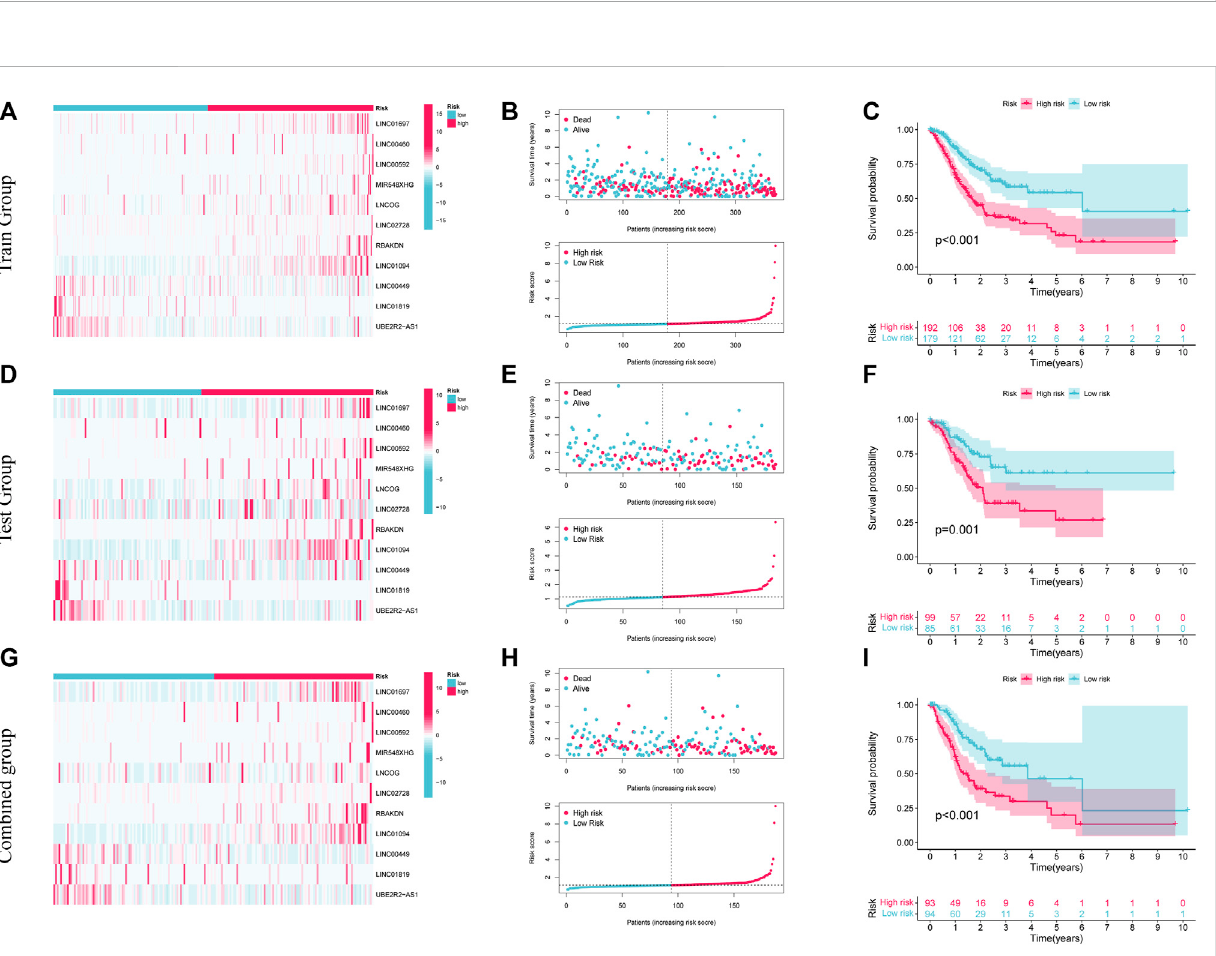
FIGURE 4 Theprognosticsigni fi canceof11AMMLsmodelsintesting,training,andwholecohorts. (A,D,G) .Survivalcurvesoftwogroupsofpatientsintraining, test, and the whole group. (B,E,H) . Model presentation of AMMLs with survival status and time based on testing, training, and the full set of risk scores. (C,F,I) . Expression of 11 AMMLs in training, test and comprehensive cohorts in high and low-risk categories. AMMLs, LncRNAs related to amino acid